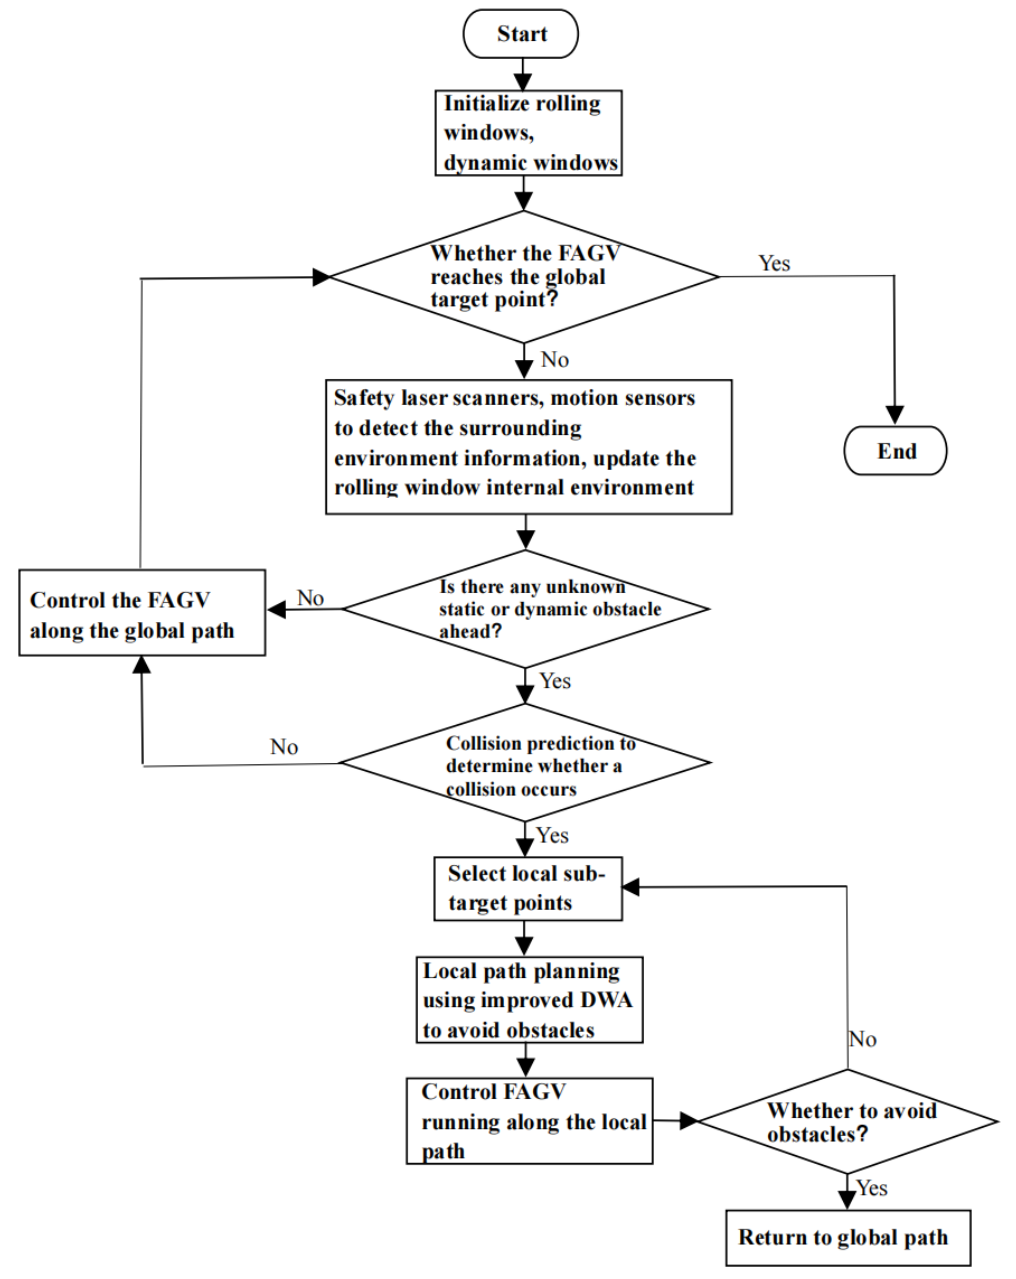
Figure 7. Flow chart of the FAGV dynamic path planning hybrid algorithm.